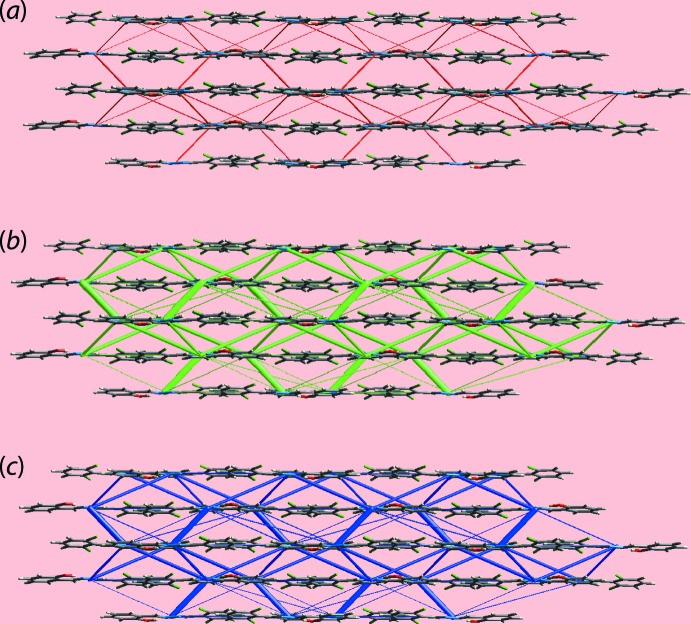
The energy frameworks calculated for (I) showing the (a) electrostatic potential force, (b) dispersion force and (c) total energy. The energy frameworks were adjusted to the same scale factor of 50 with a cut-off value of 5 kJ mol−1 within 4 × 4 × 4 unit cells